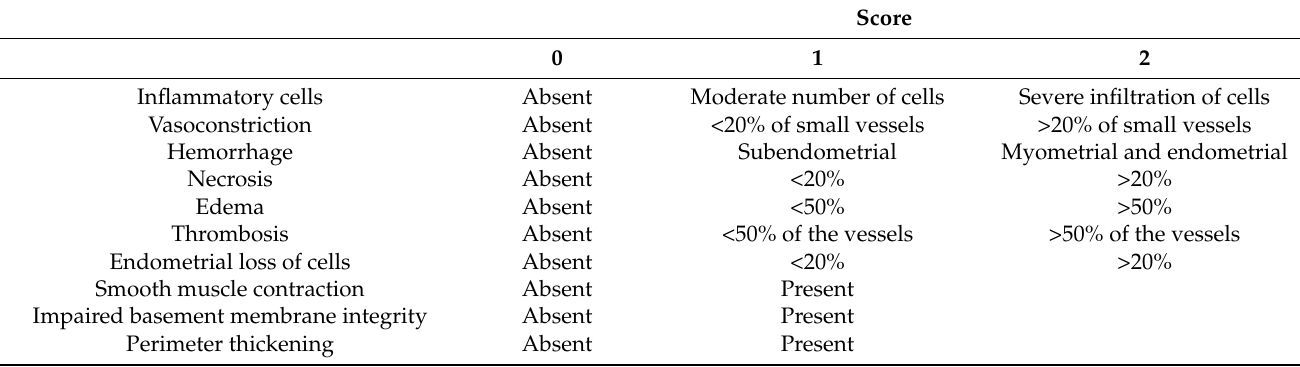
Table 2. Scoring system for the evaluation of uterus